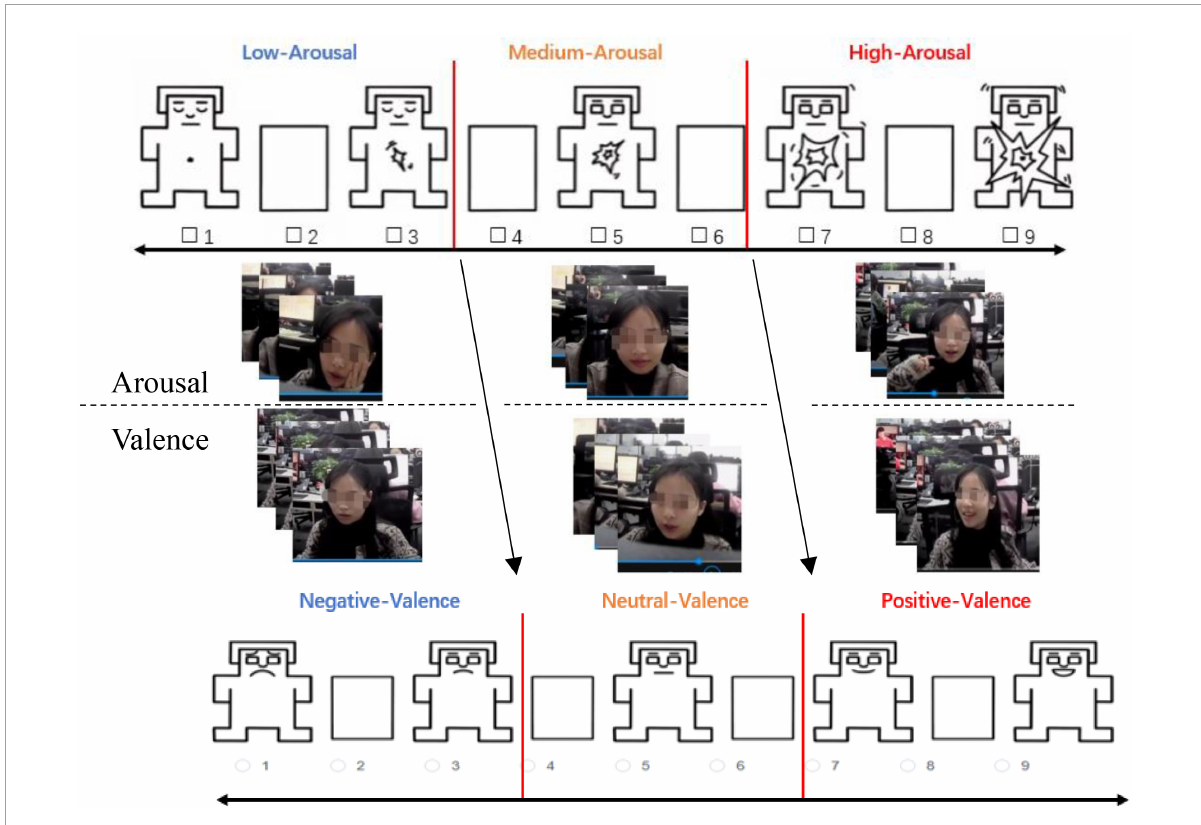
FIGURE4 Examples of customer-service staff’s auxiliary emotional judgment